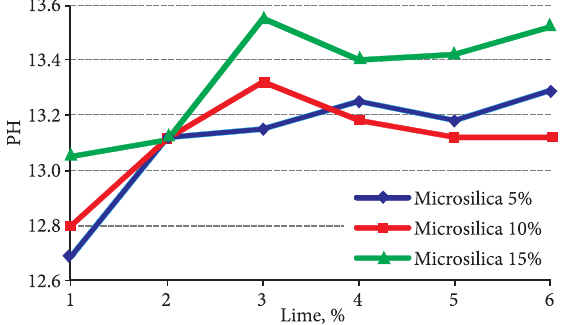
Fig. 1. Effect of adding Microsilica and Lime on the pH values